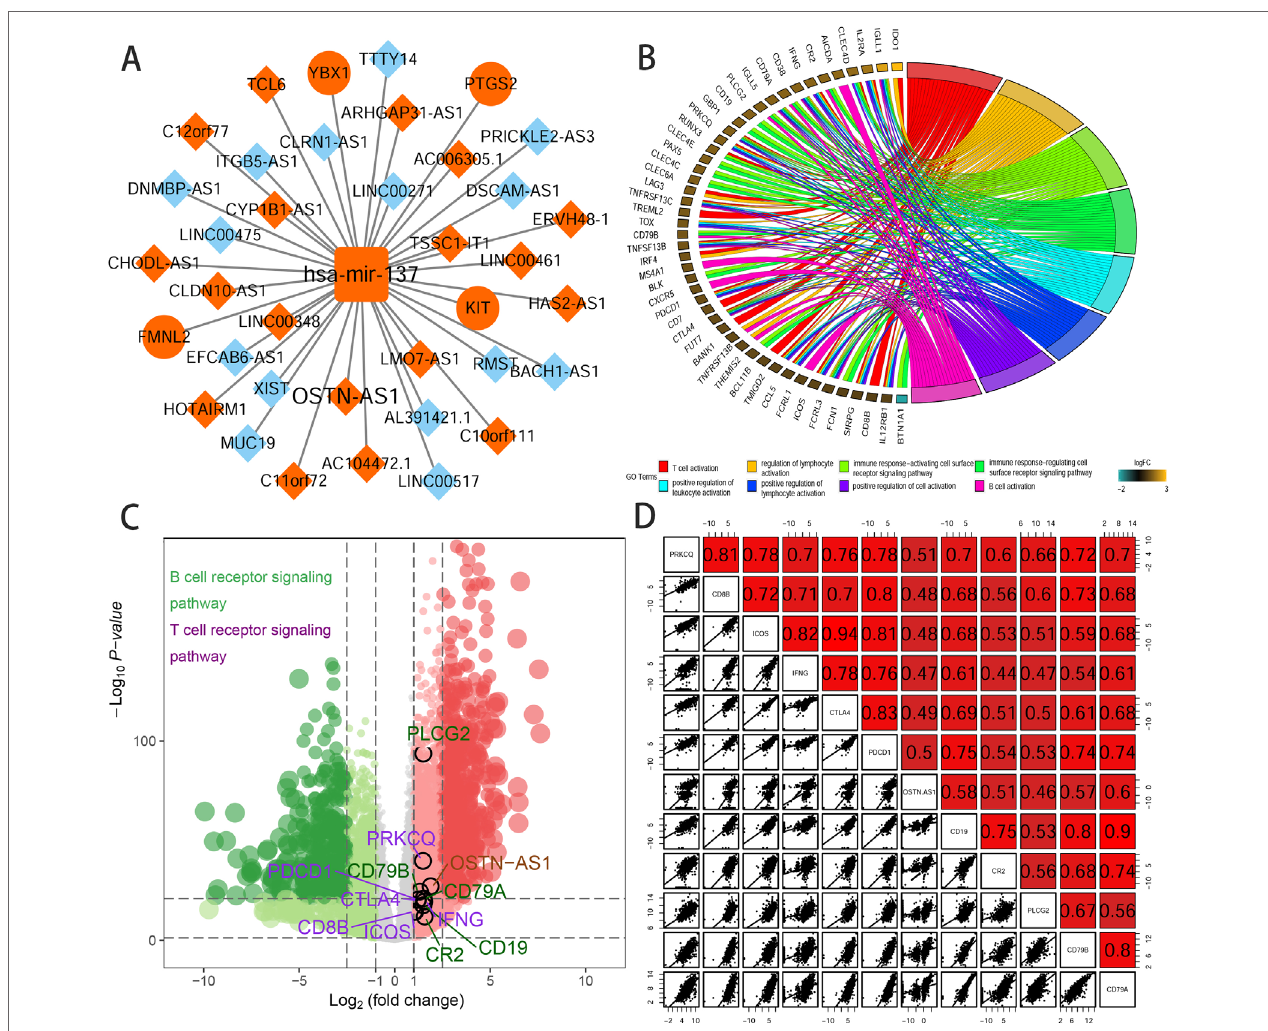
FIGURE 3 | Predicted function of OSTN-AS1. (A) The Cytoscape map of OSTN-AS1 ceRNA network from the whole ceRNA network in BRCA. (B) The function of GO analysis of mRNAs coexpressed with OSTN-AS1. (C) Volcano plot of fold changes and – log10 (adjust P value) of differentially expressed RNAs, comprising lncRNAs, miRNAs, and mRNAs. Marked nodes are important pathways related to immunity that are involved in GO analysis of OSTN-AS1. (D) Correlation between OSTNAS1 and vital genes involved in T- and B-cell receptor signaling. Numbers indicate Pearson